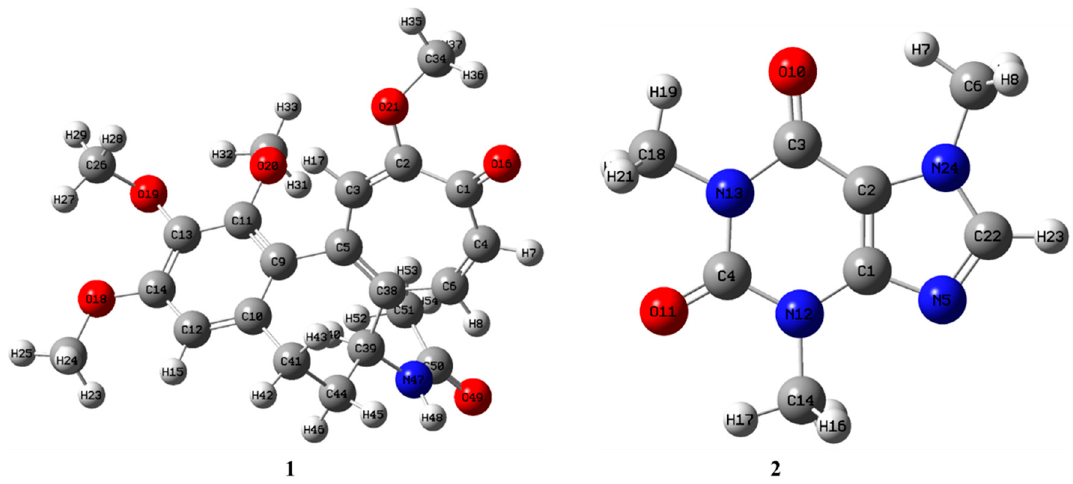
Figure 7. Optimized structures of the purified compounds.